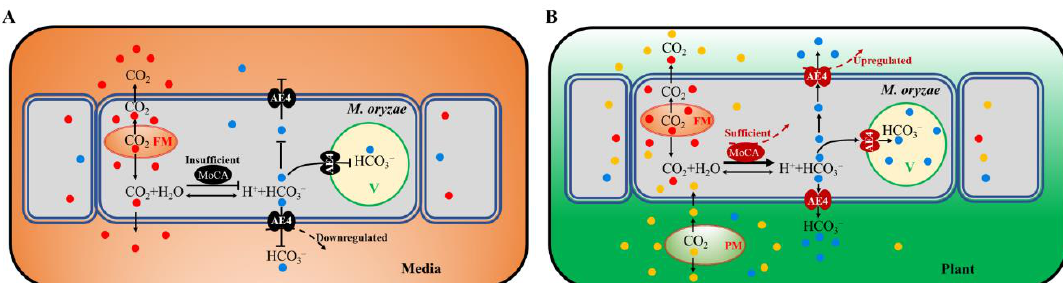
Figure 8. A pathogenic model mediated by MoAE4/MoCA (carbonic anhydrase) system. ( A ) M. oryzae is under cultivation conditions. ( B ) M. oryzae infects the host cells. FM, Fungal Mitochondrion; PM, Plant mitochondrion; V, vacuole; MoCA, M. oryzae carbonic anhydrase.